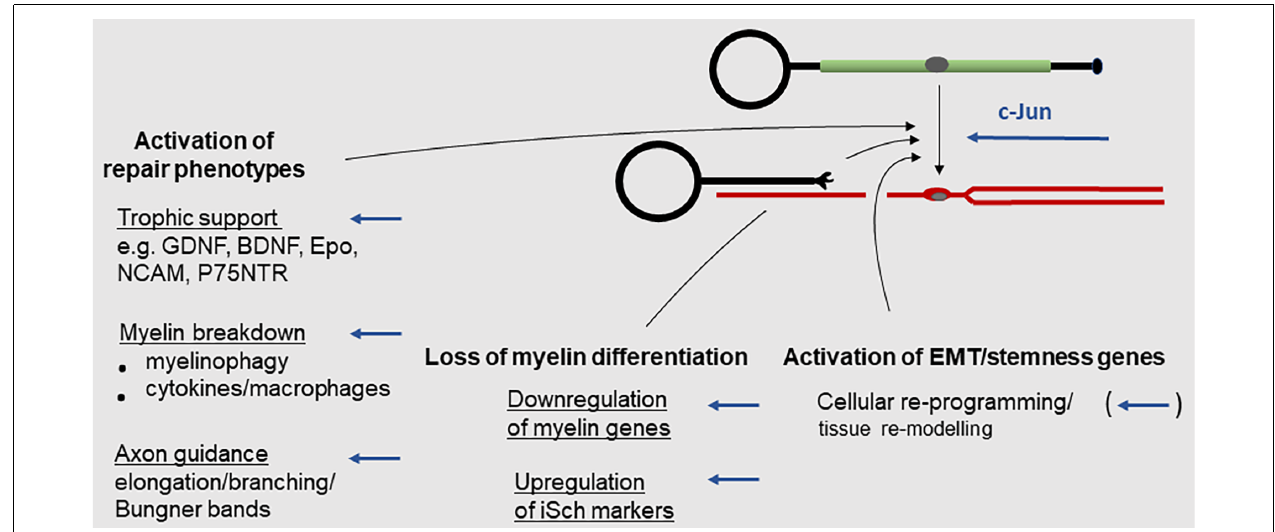
FIGURE 2 | The Schwann cell injury response. Key events during the reprogramming of myelin cells to repair Schwann cells. Arrows indicate events subject to c-Jun regulation (for references see